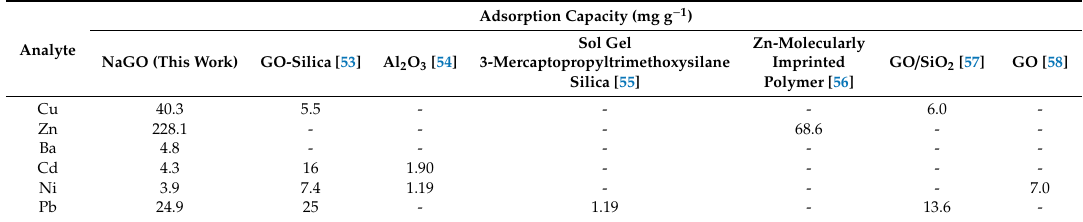
Table 1. Comparison of the adsorption capacities of NaGO and other sorbents reported in the literature.